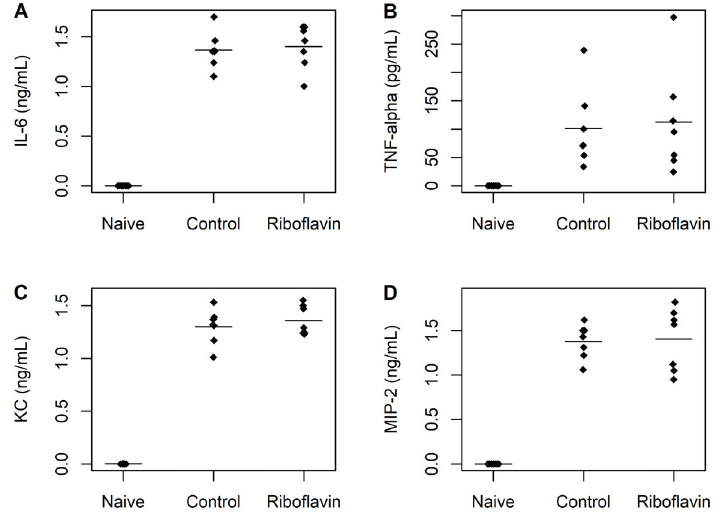
Figure 5. Concentrations of biomarkers of in fl ammation in peritoneal lavage fl uid in naïve, control, and study groups (n=7 animals per group). A , Interleukin (IL)-6; B , tumor necrosis factor (TNF)-alpha; C , keratinocyte-derived chemokine (KC); D , macrophage in fl ammatory protein (MIP)-2. The horizontal bars represent means. There were no signi fi cant differences between control and study